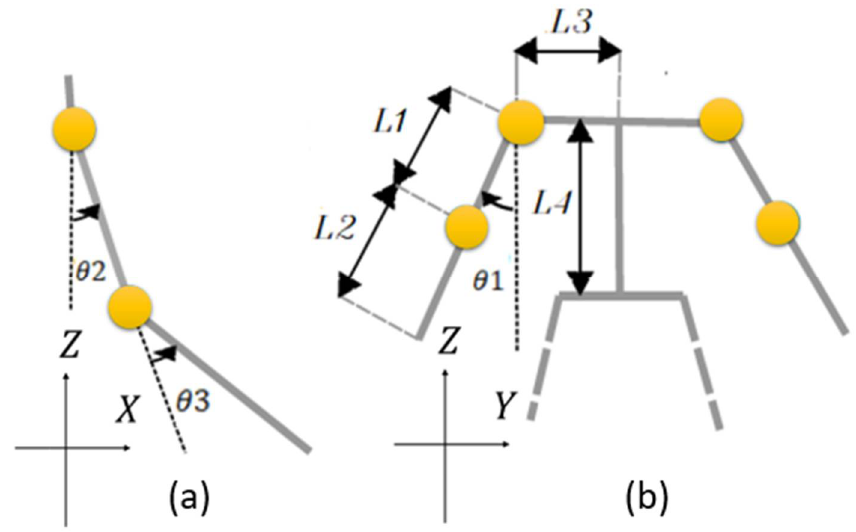
Figure 3. ( a ) Geometric configuration of shoulder flexion/extension and elbow flexion/extension joint angles noted as θ 2 and θ 3 , respectively. ( b ) Geometric configuration of shoulder abduction/adduction joint angle noted as θ 1 .